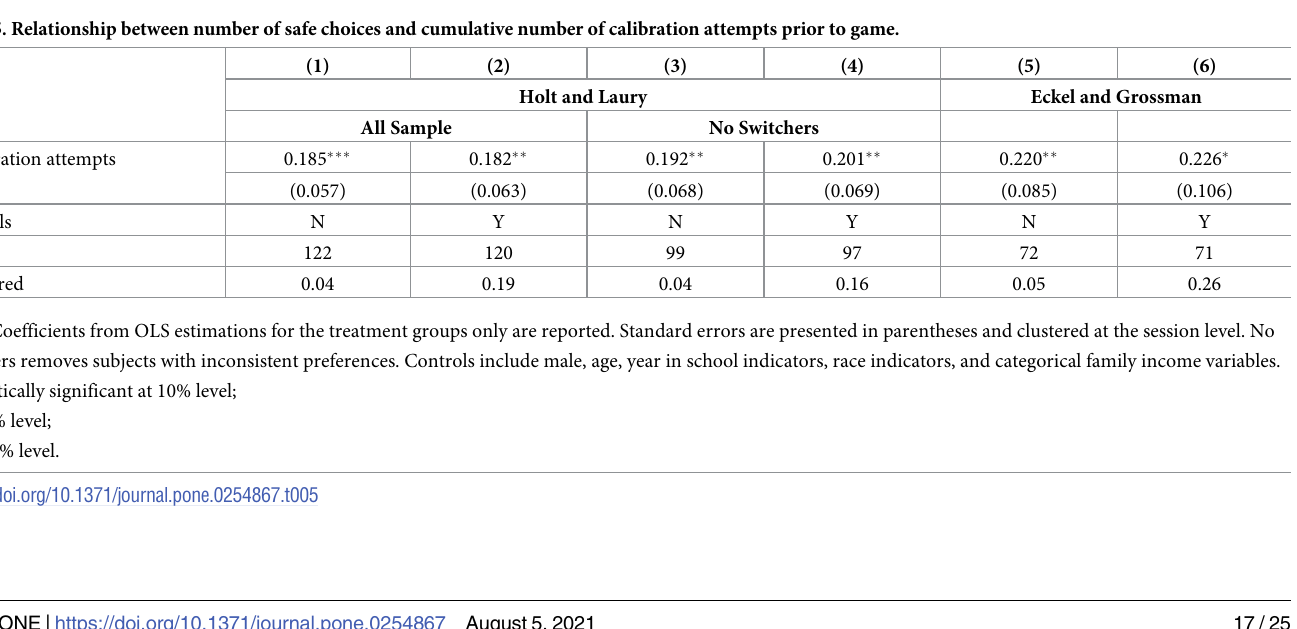
Table 5. Relationship between number of safe choices and cumulative number of calibration attempts prior to game.